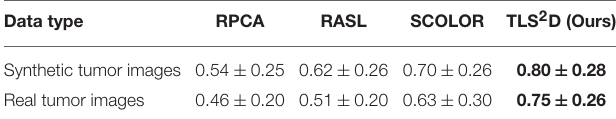
TABLE 1 | Dice values of different methods on synthetic and real MR brain tumor